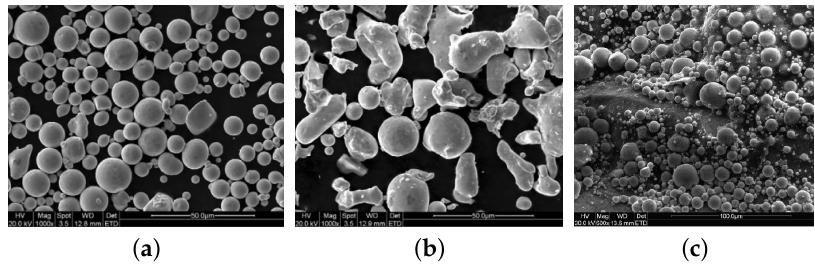
Figure 4. SEM images showing characteristic morphologies of powders produced: ( a ) using gas atomization; and ( b ) water atomization [46]. ( c ) SEM image depicts solid powders on build surface